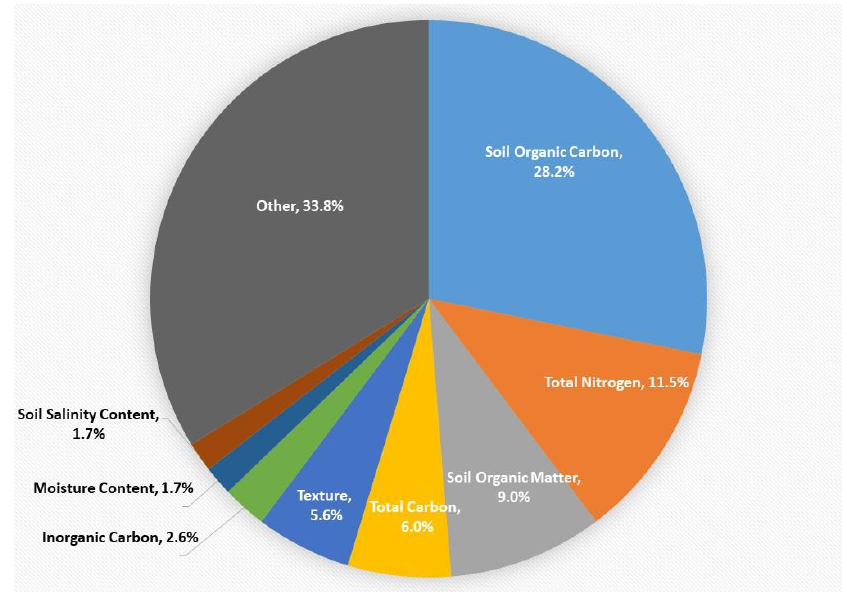
Figure 5. The proportion of soil properties reported in the reviewed articles. (Total Carbon (TC), Soil Organic Carbon (SOC), Inorganic Carbon (IC), Total Nitrogen (TN), Soil Organic Matter (SOM), Moisture Content (MC), Soil Salinity Content (SSC)) .